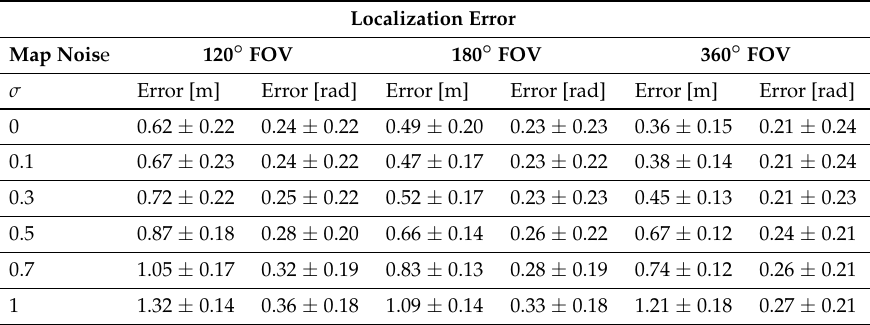
Table 1. Localization error: Sensor models with different FOVs (120 ◦ , 180 ◦ , 360 ◦ ) and different object groups (W: windows, D: door, B: board, All: window, door, board, tables and